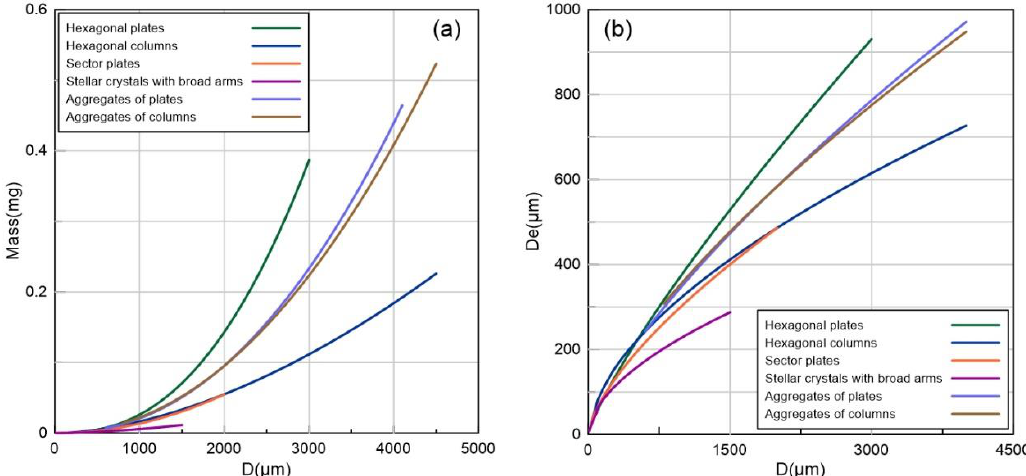
Figure 2. The relationship between mass and maximum diameter of ice crystals ( a ) and the corresponding relationship between maximum diameter and equivalent ice sphere diameter ( b ).